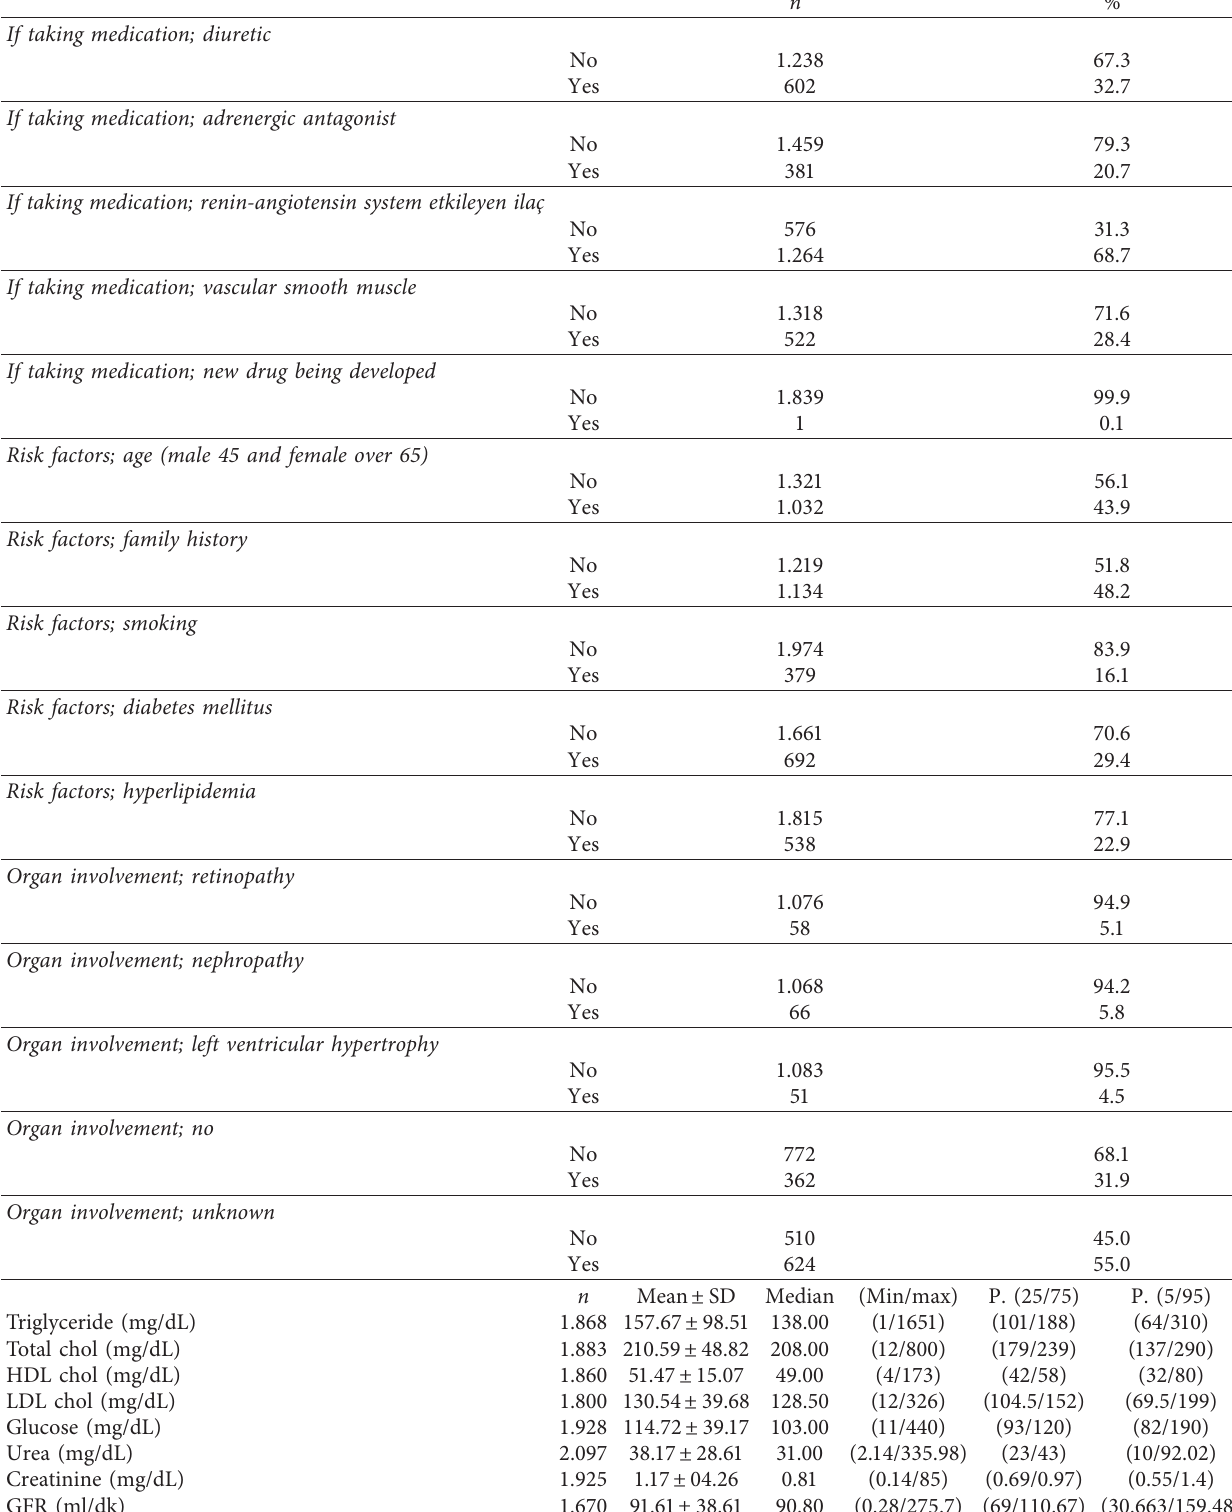
Table 2: Medications used, risk factors, organ involvement, and laboratory findings for patients with hypertension. n